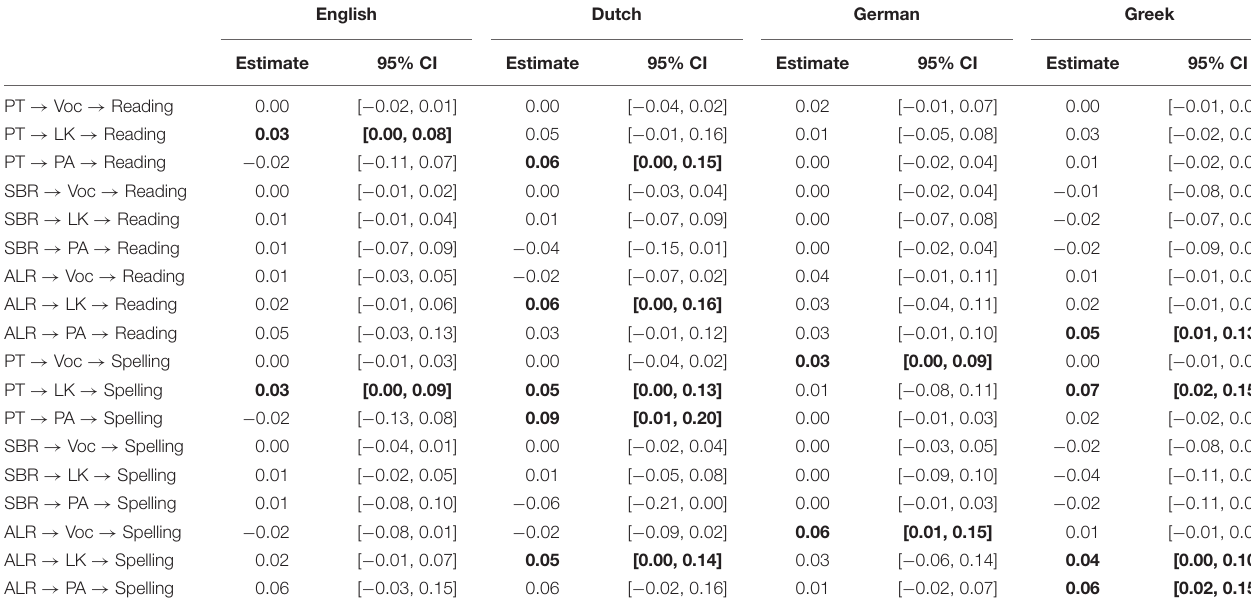
TABLE 5 | Indirect effects of HLE on literacy outcomes in each orthography. English Dutch